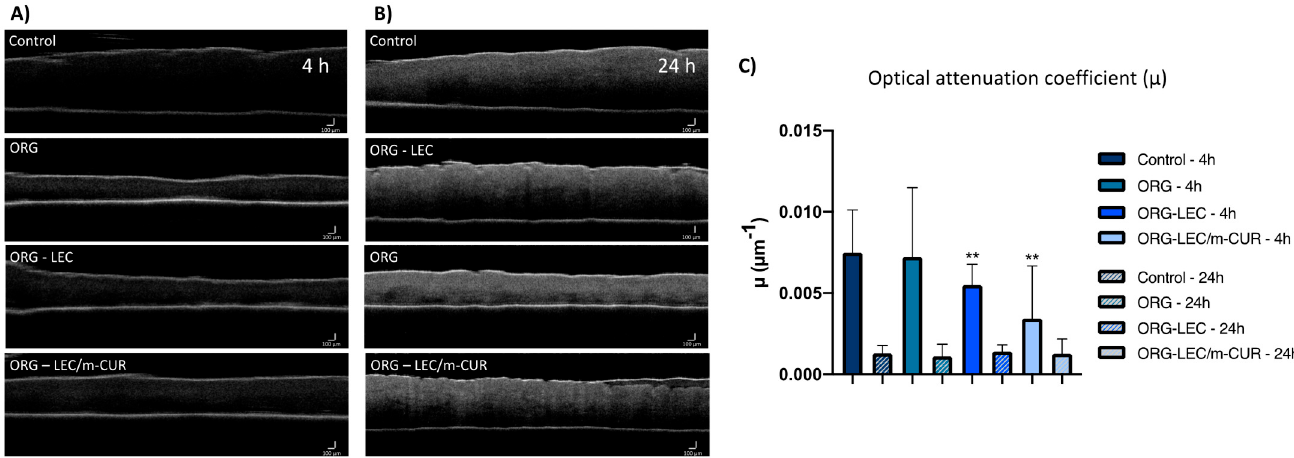
Figure 8. Optical Coherence Tomography (OCT) scans of dermatomed pig ear skin treated with ORGs for ( A ) 4 h and ( B ) 24 h, and ( C ) optical attenuation coefficient. Data are presented as mean ± SD ( n = 3). Statistical differences by one-away ANOVA test relative to control vs. ORG-LEC and control vs. ORG-LEC/m-CUR, where p < 0.01 (**).